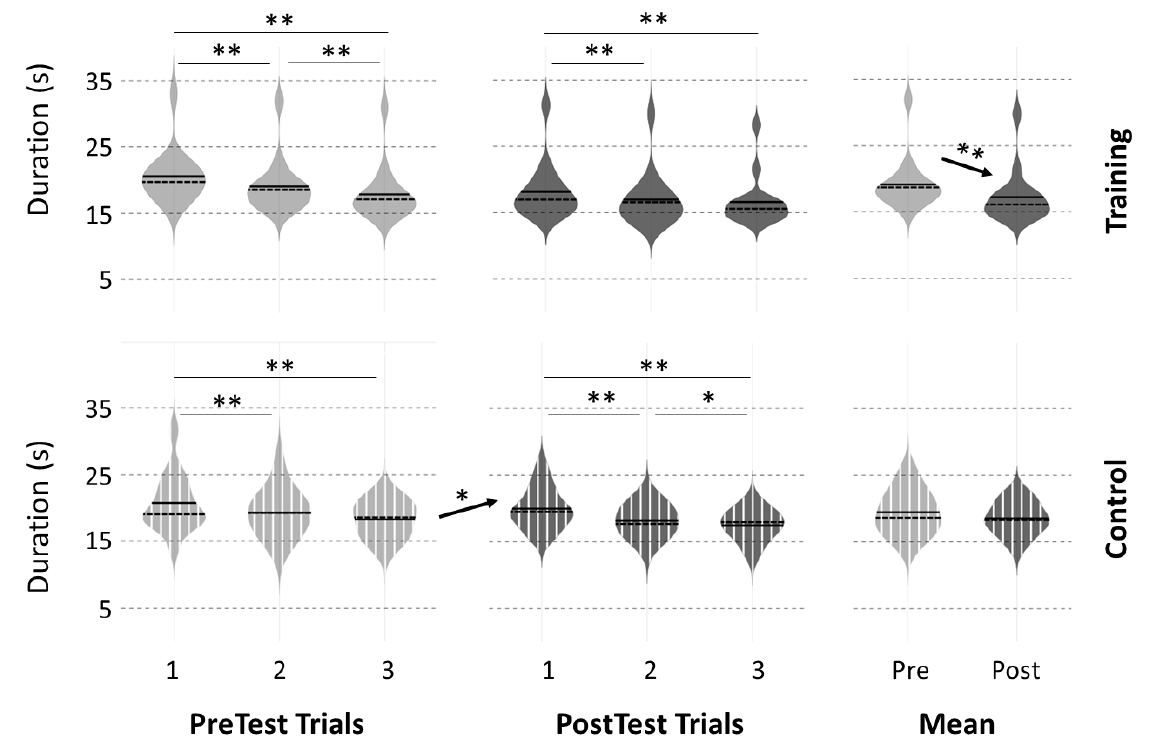
Figure 2. Violin representation of movement duration during the nine-hole peg test for each of the three PreTest and PostTest trials and the mean of the three trials for the mental-training and control groups. Significant difference: * p < 0.05, ** p <